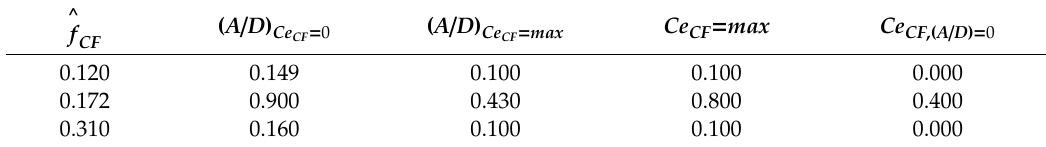
Table 1. Default set of parameters at three non-dimensional frequencies.